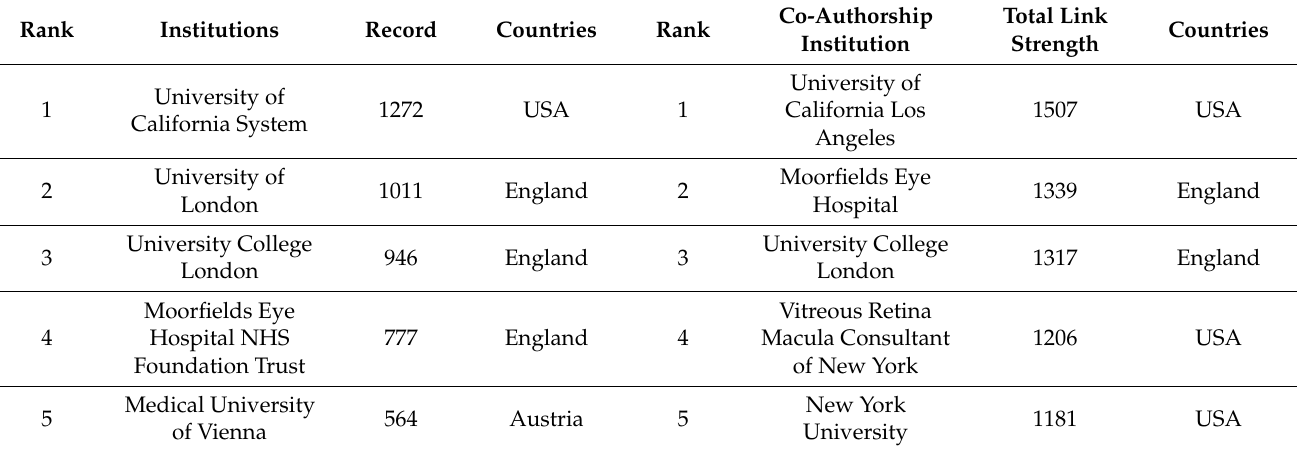
Table 3. The top 5 most productive and collaborative institutions.